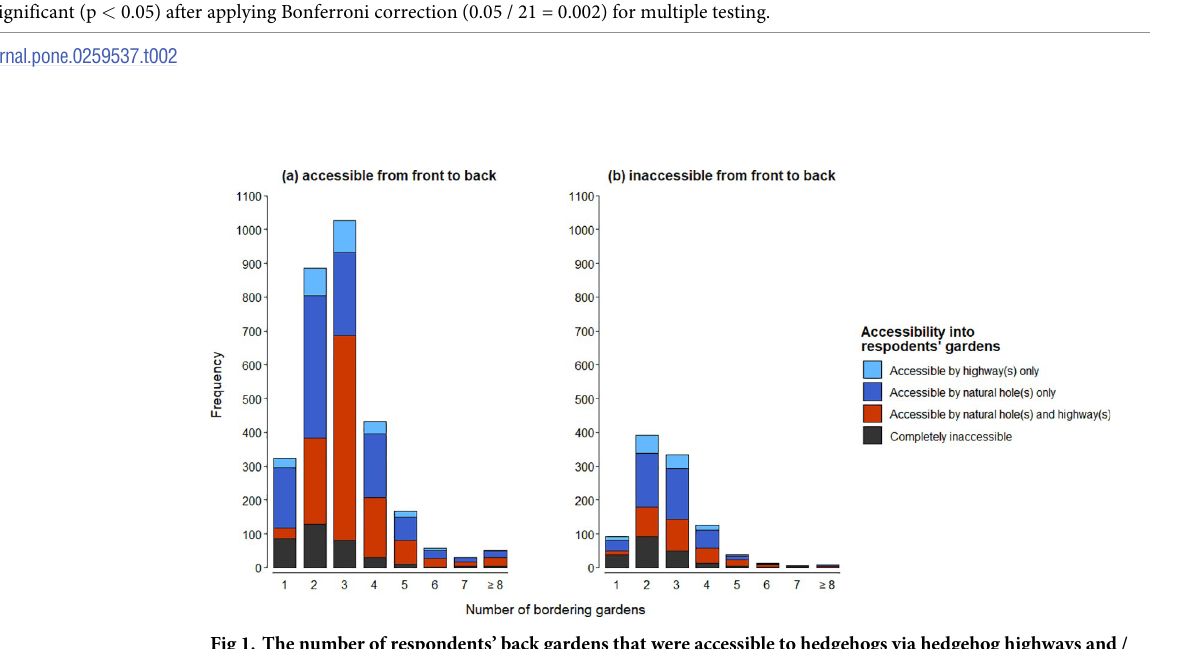
Fig 1. The number of respondents’ back gardens that were accessible to hedgehogs via hedgehog highways and / or naturally occurring holes in relation to the number of bordering gardens. Data are split into those back gardens which were (a) accessible (N = 2969) and (b) not accessible (N = 1009) from the respondent’s own front garden.